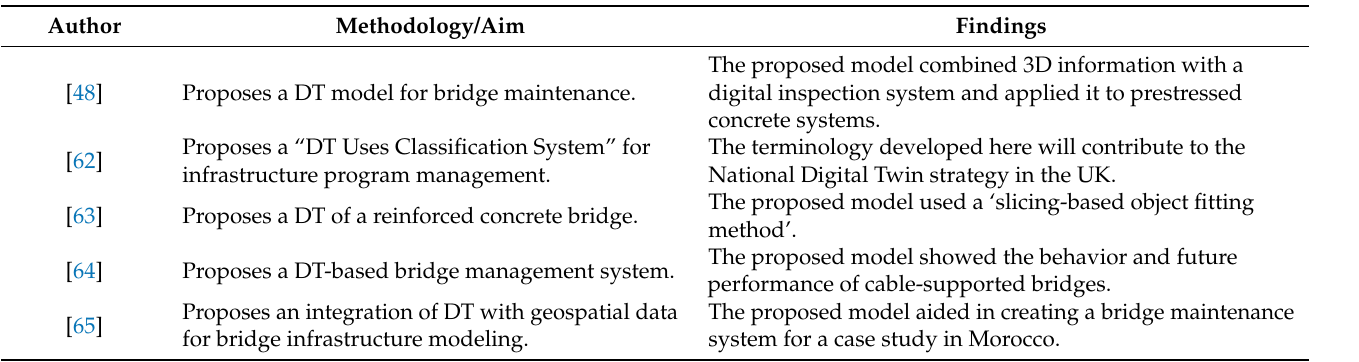
Table 5. Digital Twin for Infrastructure